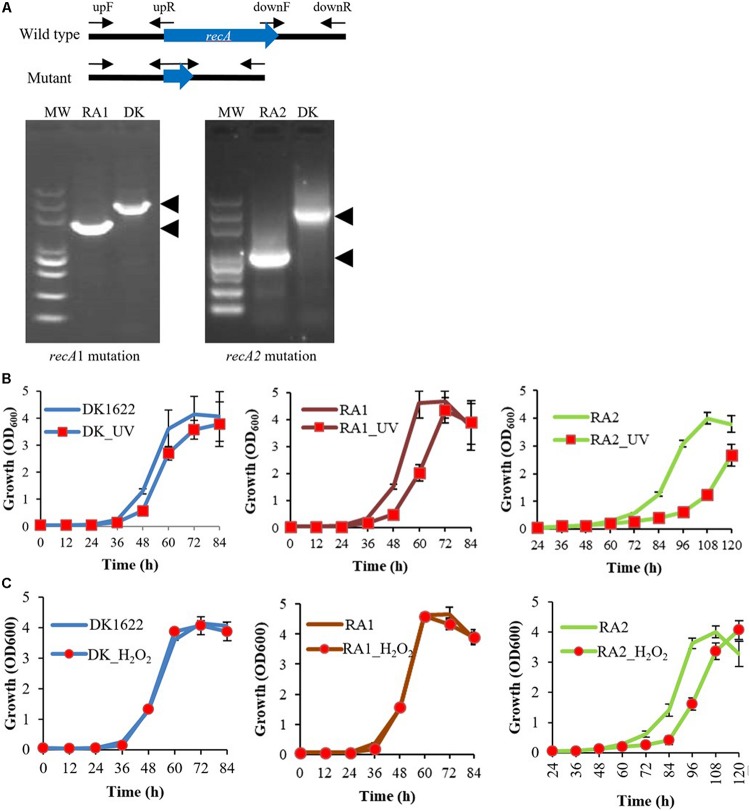
Mutations of recA1 and recA2, and their effects on the growth of M. xanthus. (A) Deletion of recA1 or recA2 in M. xanthus DK1622, using the markerless knockout plasmid pBJ113, producing the RA1 or RA2 mutants. The deletion was verified by PCR using their primer pairs (upF/downR) and sequencing. (B) Separate growth comparisons of DK1622, RA1, and RA2 with and without UV treatment at a dose of 15 J/m2. (C) Separate growth comparisons of DK1622, RA1, and RA2 with and without the H2O2 treatment at a final concentration of 3 mM for 15 min. The error bars indicate the SEM for six replicates.